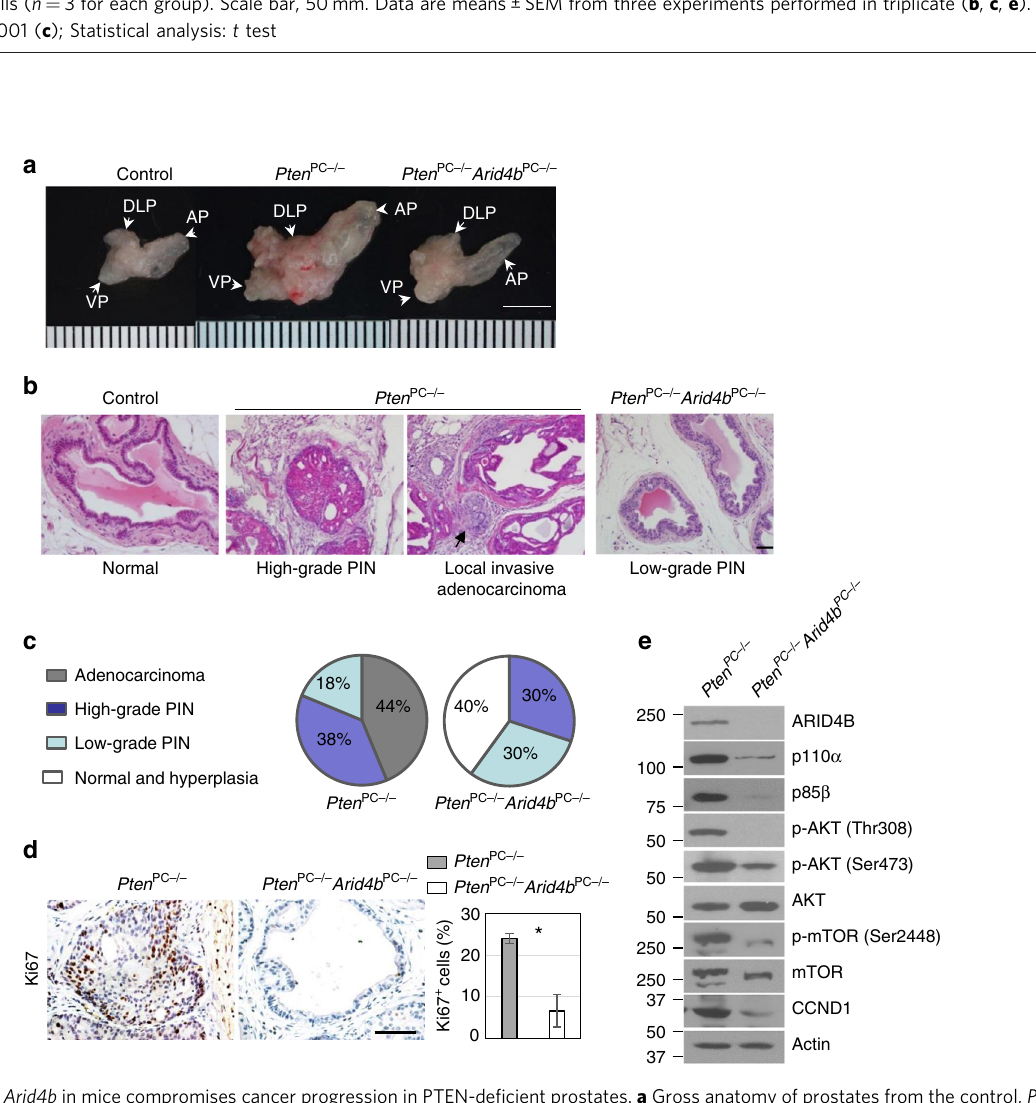
Fig. 4 Knockout of Arid4b in mice compromises cancer progression in PTEN-de fi cient prostates. a Gross anatomy of prostates from the control, Pten PC − / − , and Pten PC − / − Arid4b PC − / − mice at 5 months of age. AP anterior prostate, VP ventral prostate, DLP dorsal-lateral prostate. Scale bar, 5 mm. b Haematoxylin and eosin staining of the dorsal prostates from the control, Pten PC − / − , and Pten PC − / − Arid4b PC − / − mice at 5 months of age. Arrow: local invasive adenocarcinoma in the Pten PC − / − prostate. PIN prostatic intraepithelial neoplasia. Scale bar, 50 μ m. c Pie graphs are used to summarize prostate tumor progression in the Pten PC − / − ( n = 16) and Pten PC − / − Arid4b PC − / − mice ( n = 10) at 5 months of age. d Representative images (left) and quanti fi cation (right) of immunohistochemical Ki67 staining cells in prostates from the Pten PC − / − and Pten PC − / − Arid4b PC − / − mice at 5 months of age. Three mice from each genotype were analyzed. Data are means ± SEM. * P < 0.05; Statistical analysis: t test. Scale bar, 50 μ m. e Expression or phosphorylation of core regulators and downstream effectors of the PI3K-AKT pathway in anterior prostate of the Pten PC − / − and Pten PC − / − Arid4b PC − / − mice at 7 weeks of age were analyzed by western blots